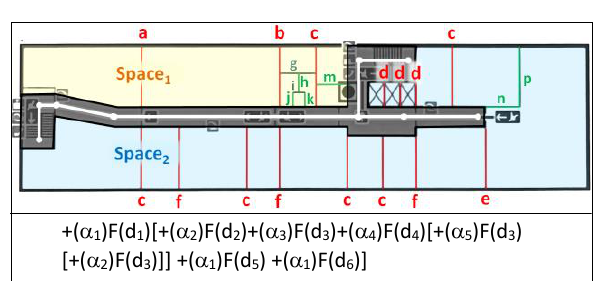
Figure 2. Different rule types and their geometric interpretation